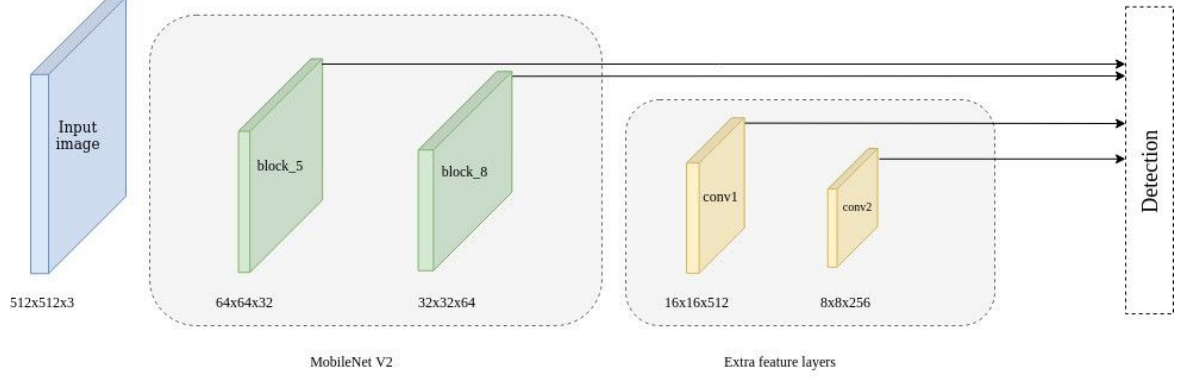
Figure 2. Target dataset scale-aware custom SSD